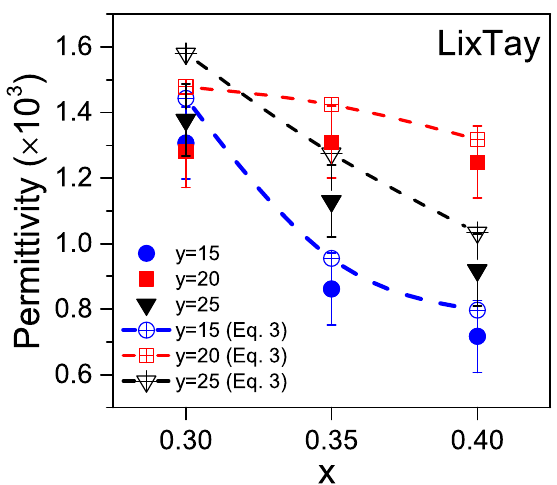
Figure 9. Composition dependence of the dielectric permittivity, at 25 ◦ C and 1 kHz, for the LKNNT ceramics, sintered at 1110 ◦ C for 2 h. The permittivity values for zero porosity, calculated from Equation (3), were also added and they are represented by open symbols. Dashed lines are guides for the eye. Table 2. Properties of the LKNNT ceramics with compositions LxTay at 25 ◦ C, including the